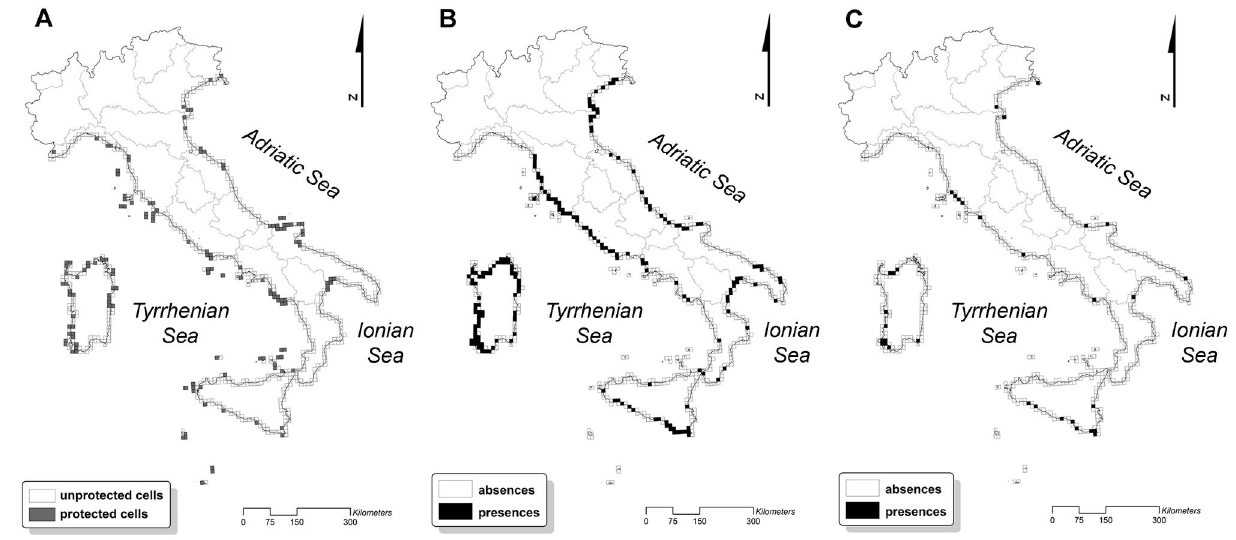
Figure 5. Efficacy of the current protected areas network. Comparison between protected areas network and distribution of the three most threatened dune habitats (2120, 2210, 2250*). ( A ) Protected UTM grid cells; ( B ) UTM grid cells where at least one of the three threatened dune habitats currently occurs; ( C ) UTM grid cells with the predicted future distribution of the three dune habitats (A2 emission